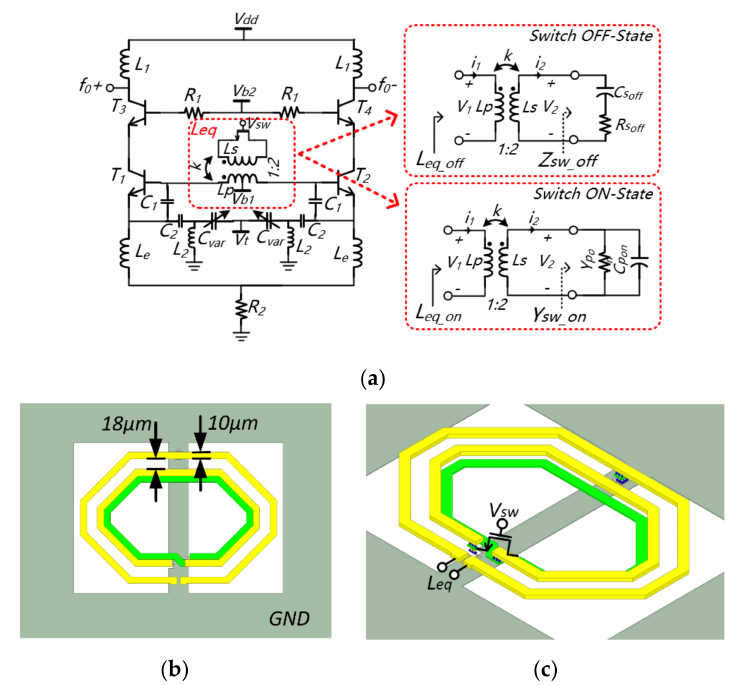
Figure 2. ( a ) Schematic of the Colpitts voltage-controlled oscillator (VCO), and equivalent circuits of switched inductor at switch ON / OFF state; ( b ) top view of the Q-boosted switched inductor; ( c ) 3-D view of the Q-boosted switched inductor with 1:2 inductor-loaded